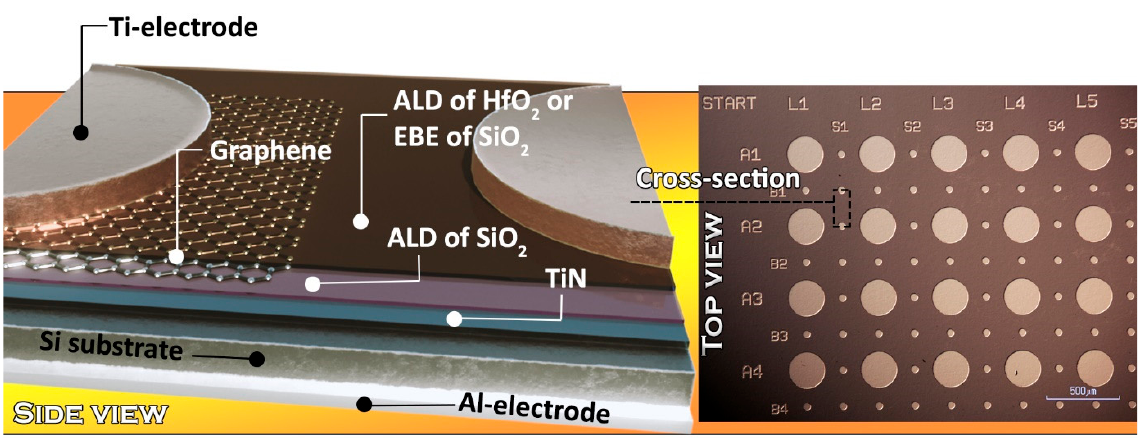
Figure 1. Graphic representation of the stacked nanostructures combined into one figure with and without graphene interface layers devised for resistive switching ( left panel ) and bird’s-eye-view through an optical microscope of the Ti electrode matrix fabricated on the topmost oxide layer by maskless photolithography ( right panel ).